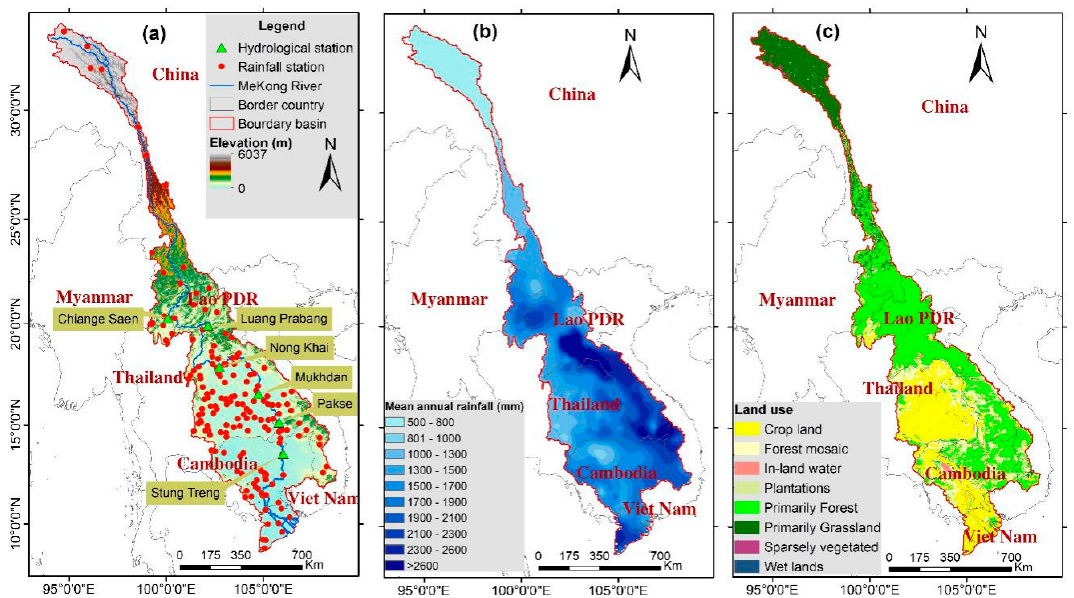
Figure 1. Map of the Mekong River Basin: ( a ) Rainfall and the hydrological station network; ( b ) mean annual rainfall; ( c ) land use map (Data source: MRC [33]).